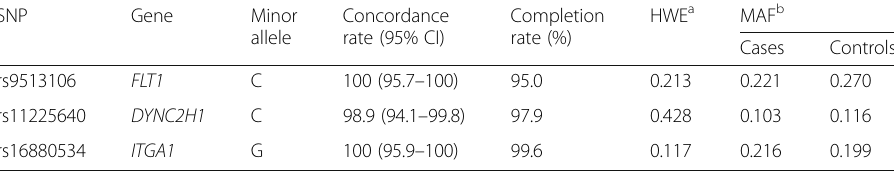
Table 3 Summary metrics and allelic frequencies of genotyped SNPs in the discovery study SNP Gene Minor